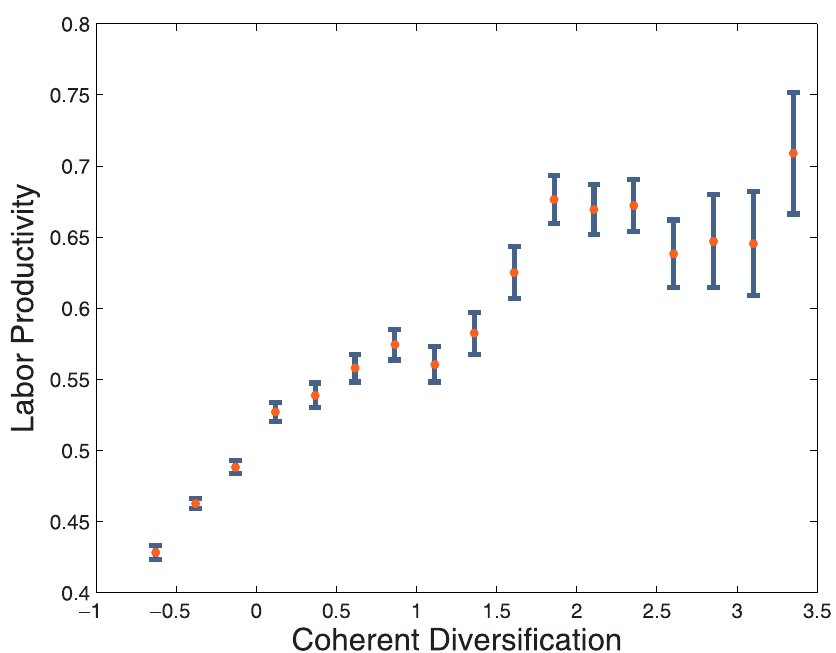
Fig 7. Coherent diversification VS labor productivity. The graph plots the binned values of Coherent Diversification ( Γ ) of the firms in our sample against the intra-bin quantiles of labor productivity. The clear positive association between Γ and labor productivity suggests that the Coherent Diversification of technological portfolios captures relevant information about the corporate productive structure.